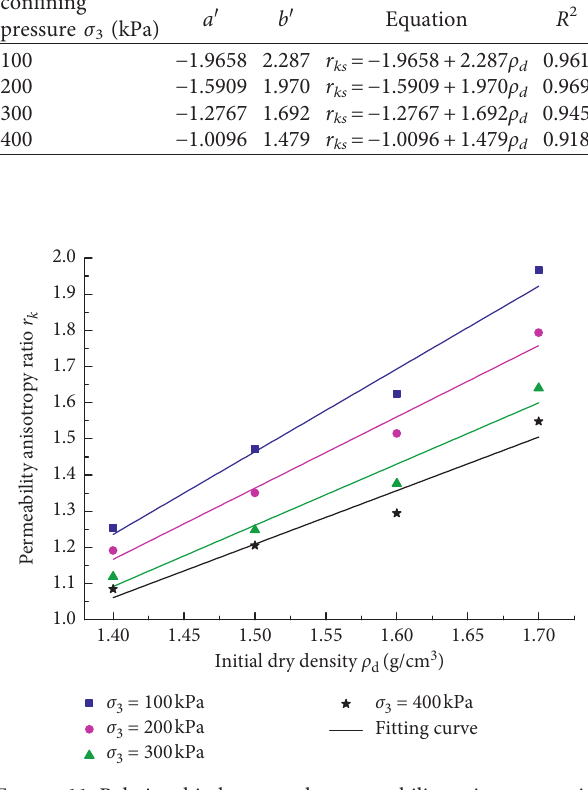
Figure 11: Relationship between the permeability anisotropy ratio and the initial dry density under K 0